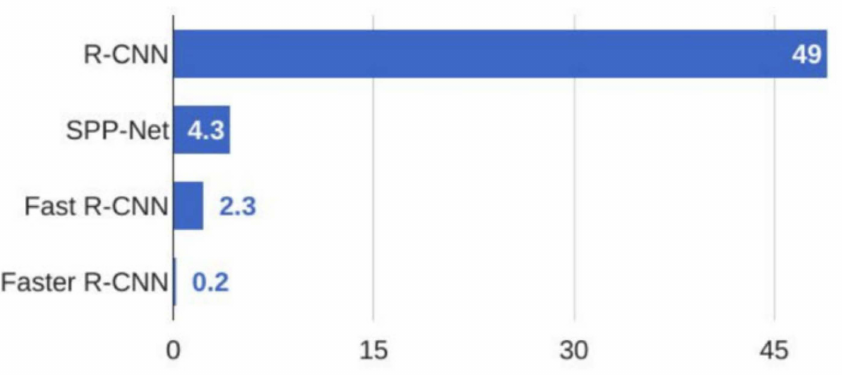
Figure 9. Comparison of Test-Time Speed between R-CNN, SPP-Net, Fast R-CNN and Faster